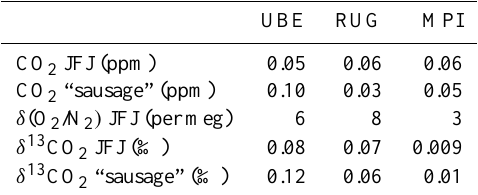
Table 1. Average standard errors in the mean of the duplicate or trip- licate flasks for the CO 2 , δ (O 2 /N 2 ) and δ 13 CO 2 measurements from each of the three laboratories for the flasks sampled at Jungfraujoch as well as for the flasks from the “sausage”